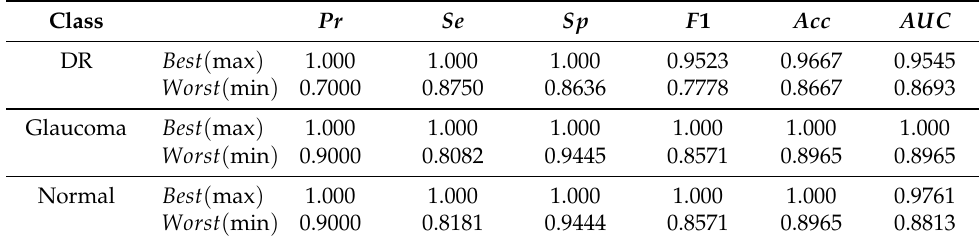
Table 9. The best and the worst classification results for Dataset_2.